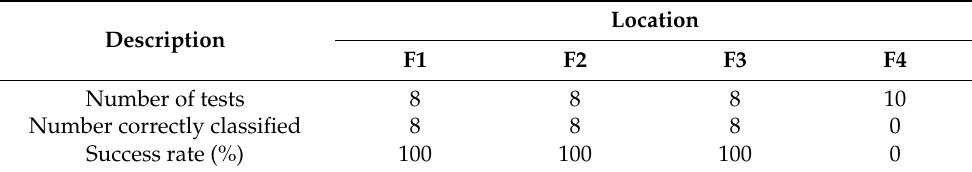
Table 2. Results of the